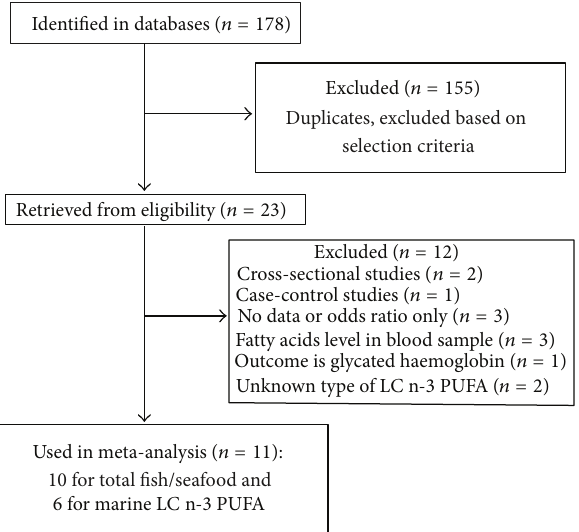
Figure 1: Process of study